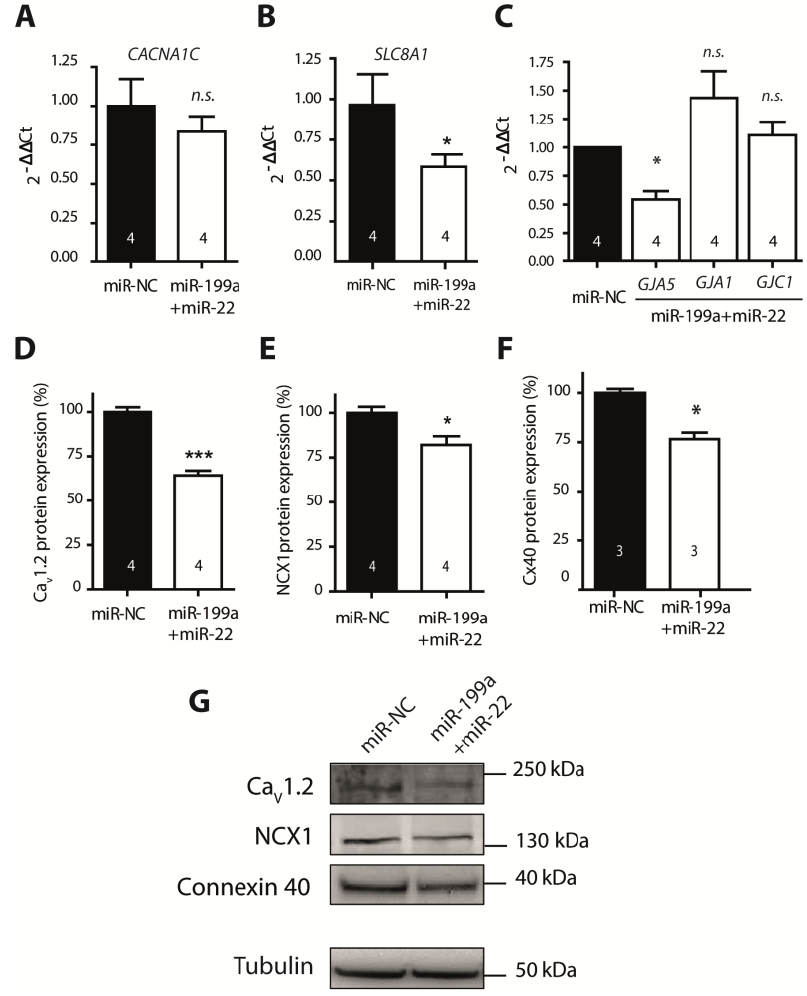
Figure 2. Gene and protein expression ( A – C ). Expression levels of CACNA1C , SLC8A1 and the connexin members, GJA5 , GJA1 and GJC1 in HL-1 cells transfected with miR-NC (black columns) or miR-199a+miR-22 (white columns). Normalized to miR-NC ( D – F ). Protein expression levels of Cav1.2, NCX1 and Cx40, normalized to the endogenous control, tubulin ( G ). Representative WB experiments in HL-1 cells transfected with miR-22+199a and miR-NC. All proteins (Cav1.2, NCX1, connexin 40 and tubulin) were blotted on the same gel. This is a representative image of four independent experiments. Numbers within columns represent the number of independent experiments done. * p < 0.05, *** p < 0.0001, n.s.: